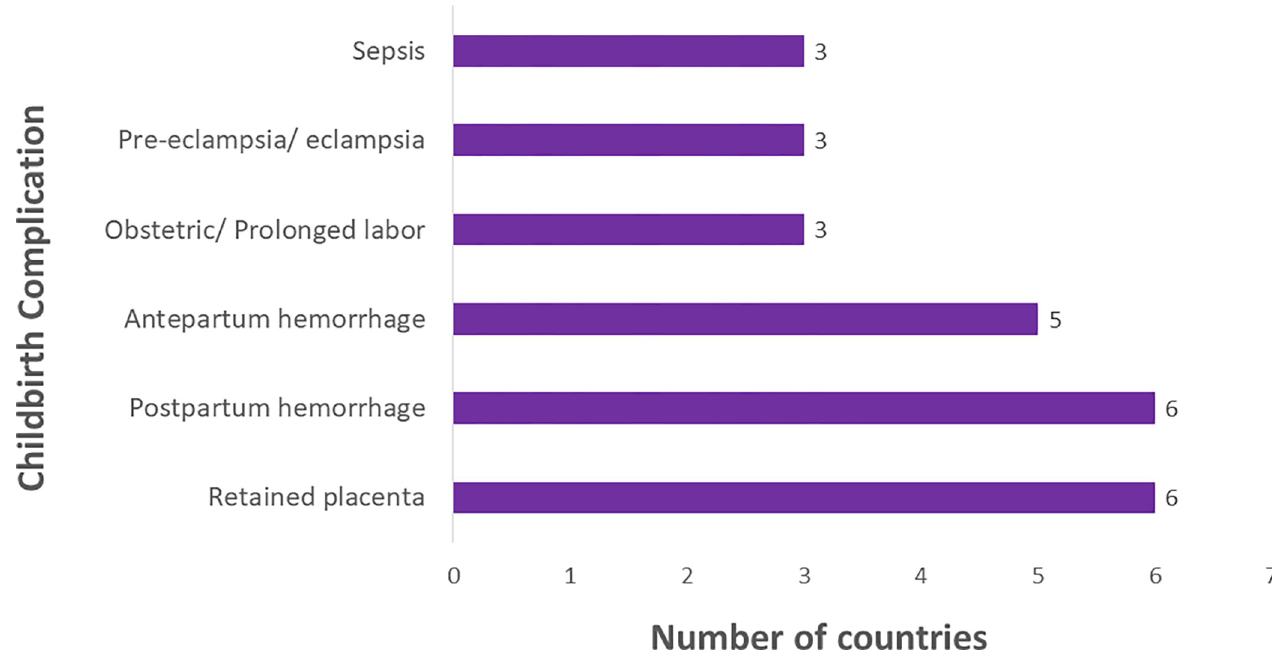
Fig 2. Maternal complications of